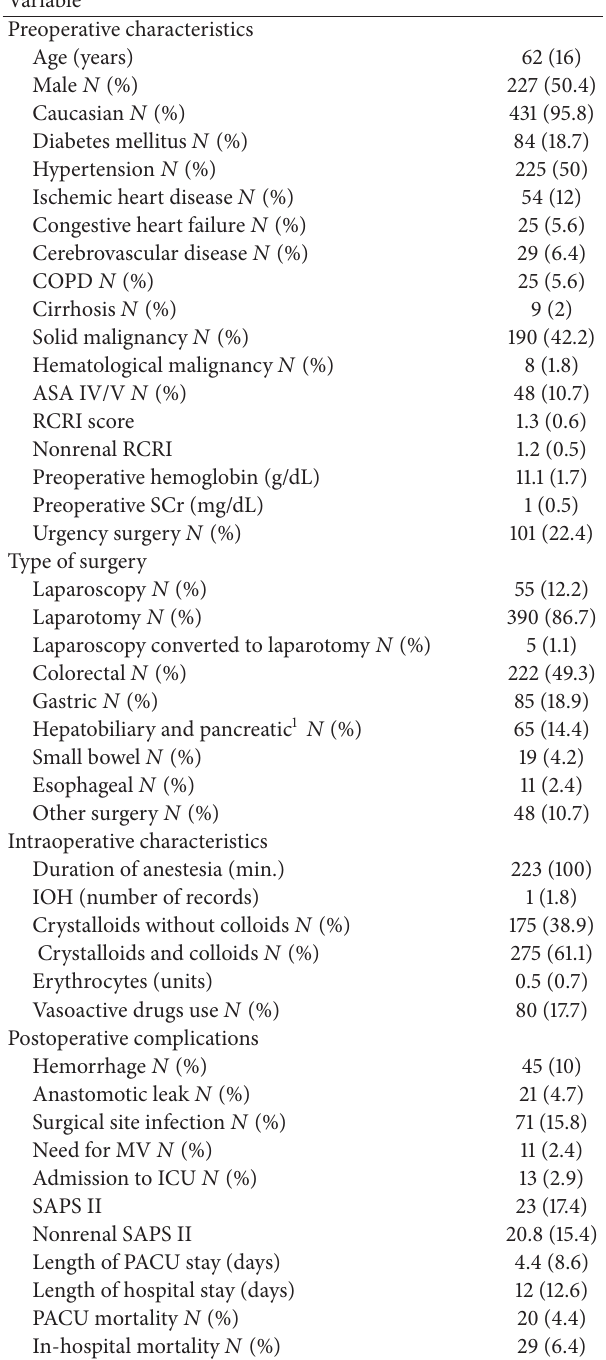
Table 1: Preoperative characteristics, type of surgery, intraoperative characteristics, postoperative complications, length of stay, and mortality of patients ( 𝑁 = 450 ) undergoing major nonvascular abdominal